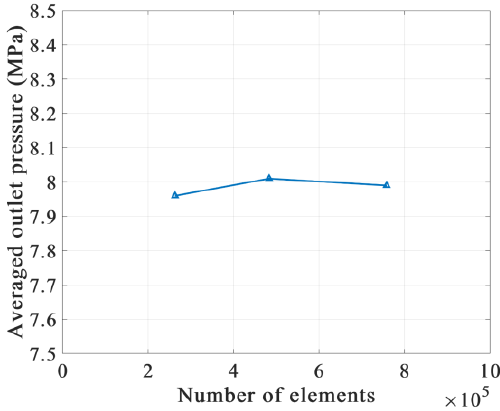
Figure 9. Relation between number of mesh elements and averaged outlet pressure.